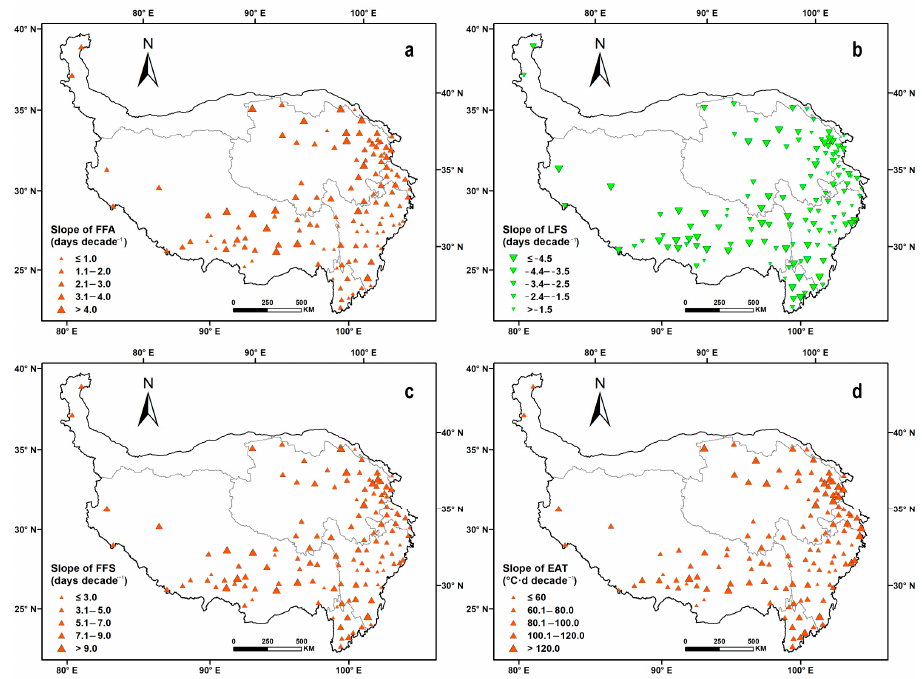
Figure 5. Change trends of first and last frost days and frost-free periods on the Qinghai–Tibetan Plateau during the 1978–2017 period. a–d represent the spatial distribution of annual change rates of FFA, LFS, FFS and EAT at the site level.